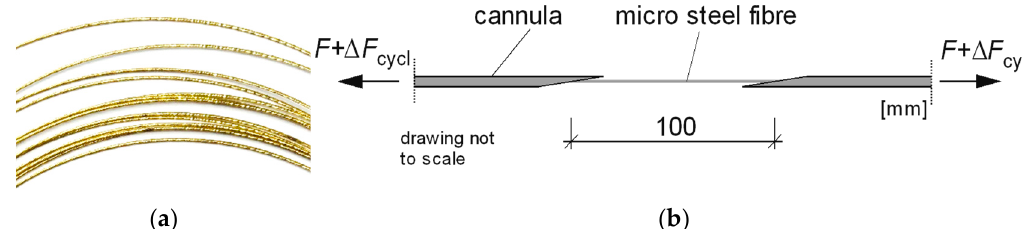
Figure 2. “Truss” of the ordered high-strength micro steel fibre ( a ) and test specimen ( b ).